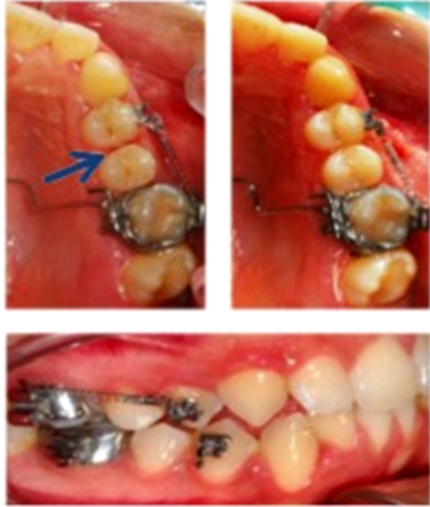
Figure 2. Performed interproximal reduction of upper first premolar to be extracted on the test side (blue arrow). closed-coil spring exerting ∼ 0.5 N force was attached between the premolar and molar and evaluated after 7 days of force application in these intra-oral